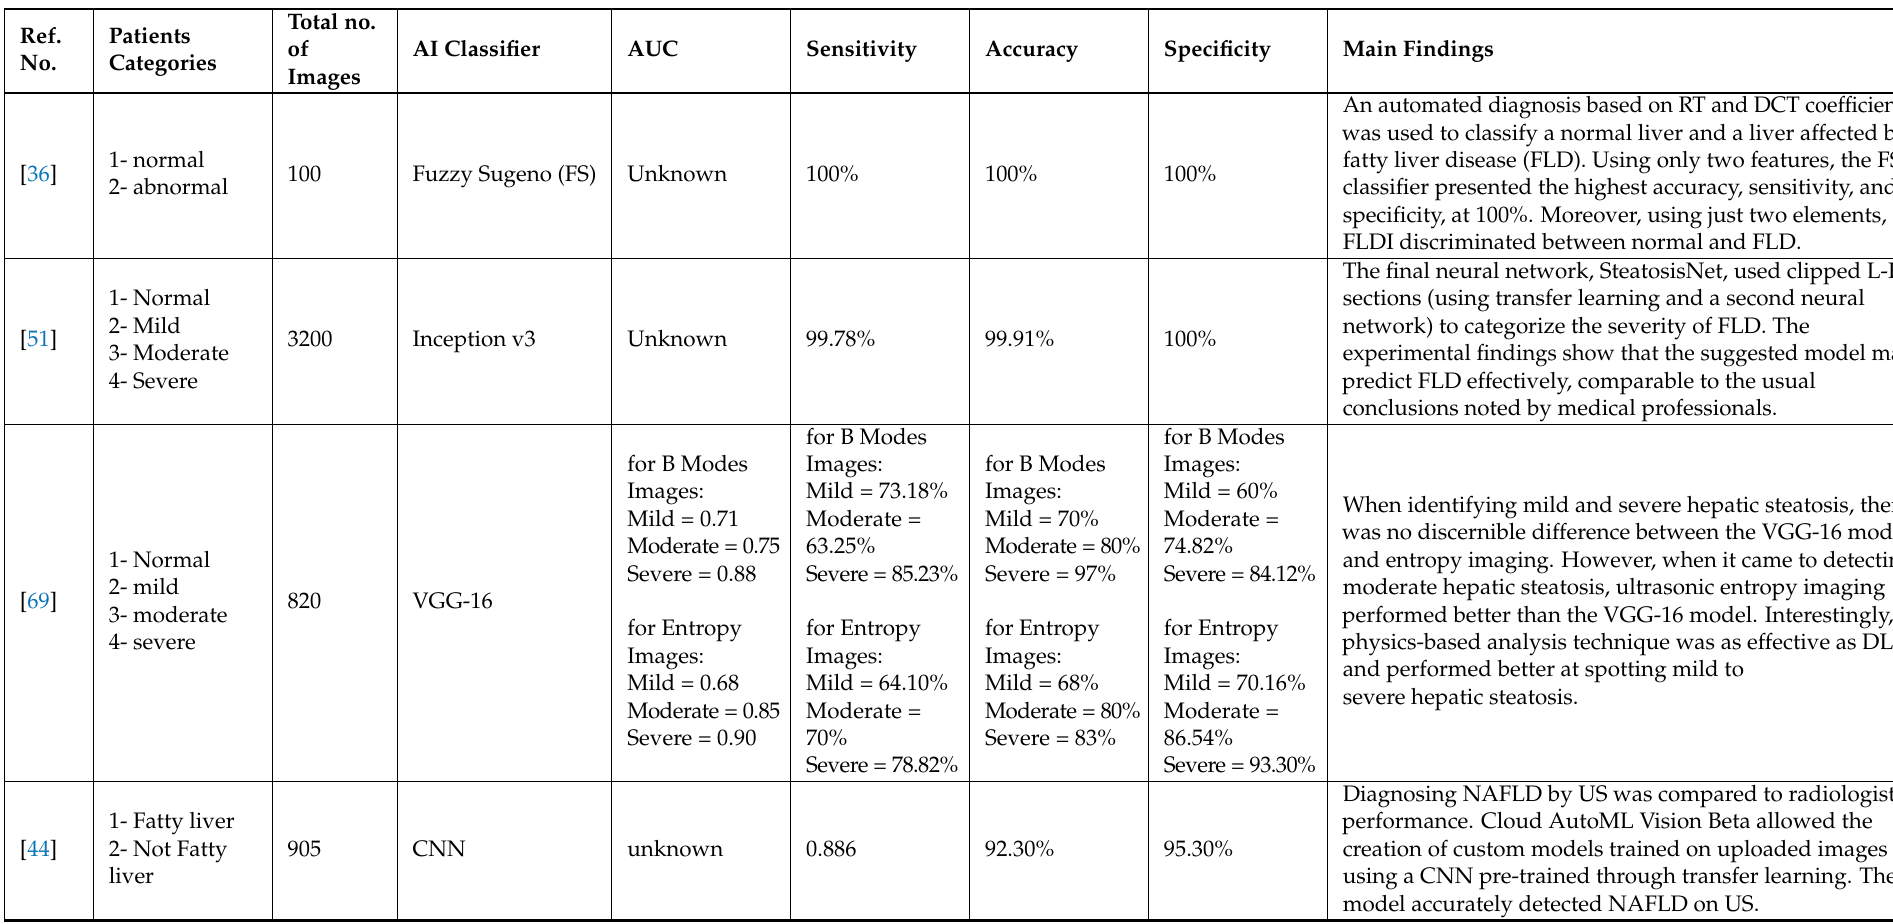
Table 5. Results of included